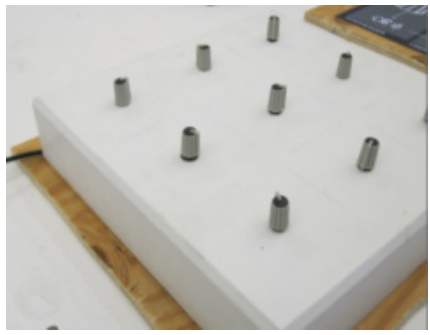
Figure 4. Internal knob characteristics